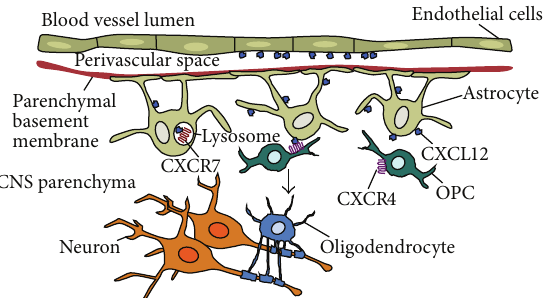
Figure 1: Chemokines mediate repair in the adult CNS. Following demyelination, CXCL12 and its receptors, CXCR4 and CXCR7, are upregulated on astrocytes and endothelial cells. CXCL12 binding to CXCR4 on OPCs induces proliferation and maturation into myelin- producing oligodendrocytes. CXCR7 regulates CXCR4 activation by sequestering CXCL12 into lysosomal compartments for degrada-